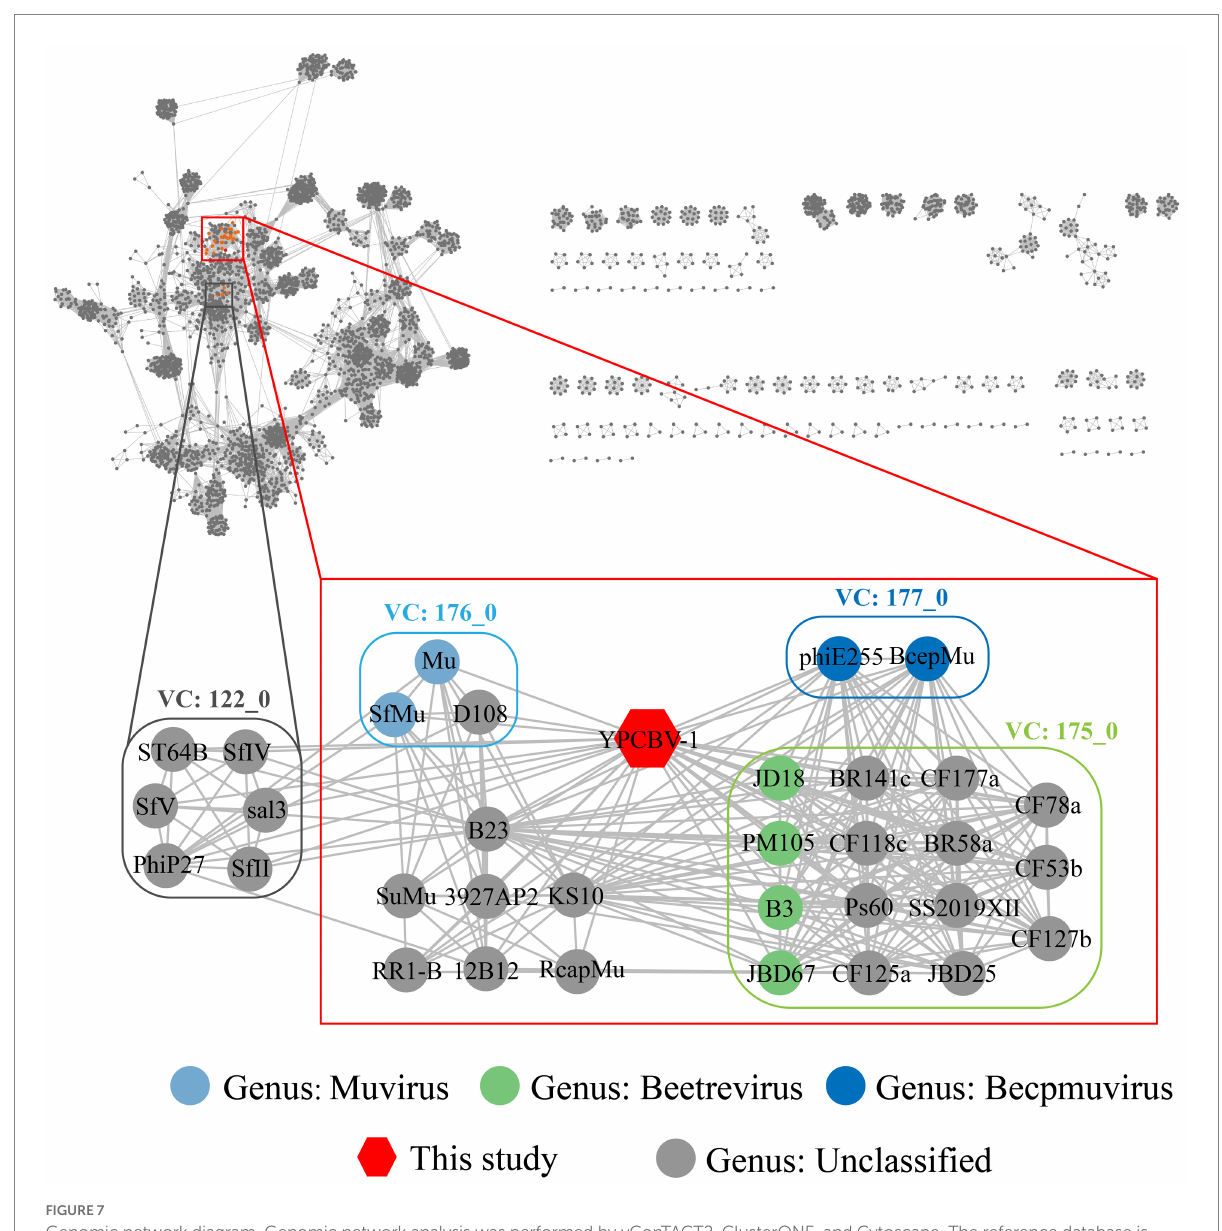
FIGURE 7 Genomic network diagram. Genomic network analysis was performed by vConTACT2, ClusterONE, and Cytoscape. The reference database is Prokaryotic Viral RefSeq211-Merged (Last updated in June 2022) and the top 20 similarity sequences in Genbank were added. Duplicate and unassociated sequences are removed. Edges indicate the presence of correlation between viral sequences, and virus clusters are shown as differently colored boxes. The classification status of viruses is derived from the ICTV (July